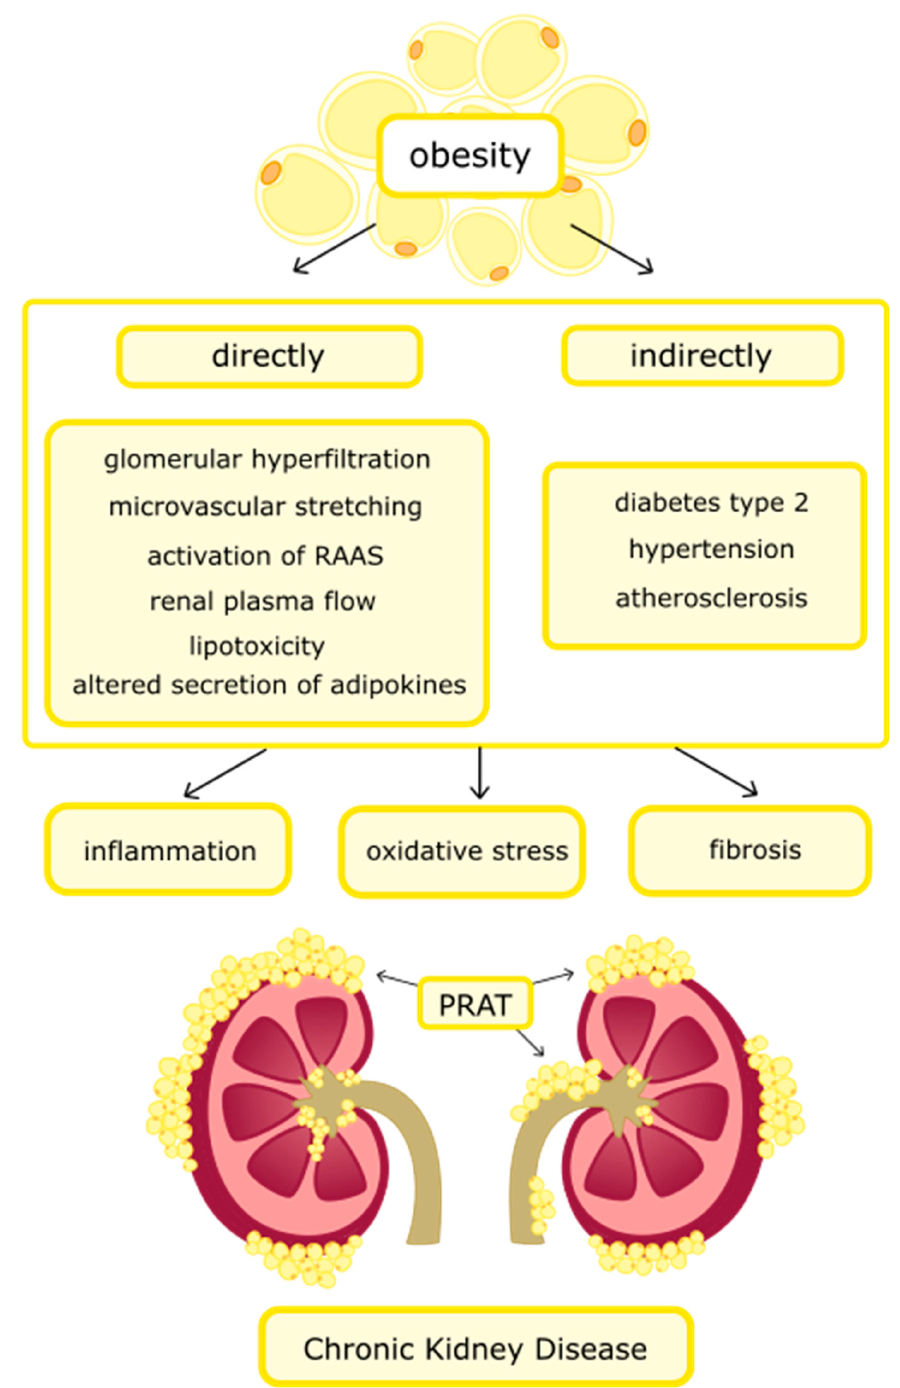
Figure 2. The direct and indirect impact of obesity on the development of chronic kidney disease. Abbreviations: RAAS—renin-angiotensin-aldosterone system; PRAT—perirenal adipose